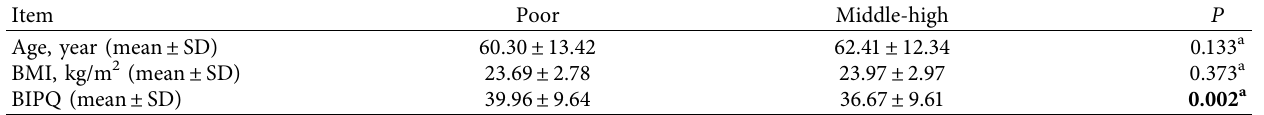
Table 6: Characteristics of poor group versus middle-high group (continuous data).